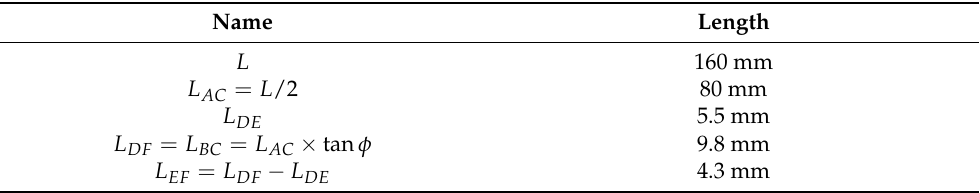
Figure 7. Diagram of the distance between infrared tubes ( L is the distance between the infrared transmitting tube and infrared receiving tube). ( a ) Schematic diagram of detection device spacing. ( b ) Schematic diagram of receiving pipe spacing (A is the midpoint of L, D is the midpoint of the infrared tube, E is the inner foot point of the infrared tube, and F is the vertical point of A on the acrylic plate). Table 2. Parameter Settings.